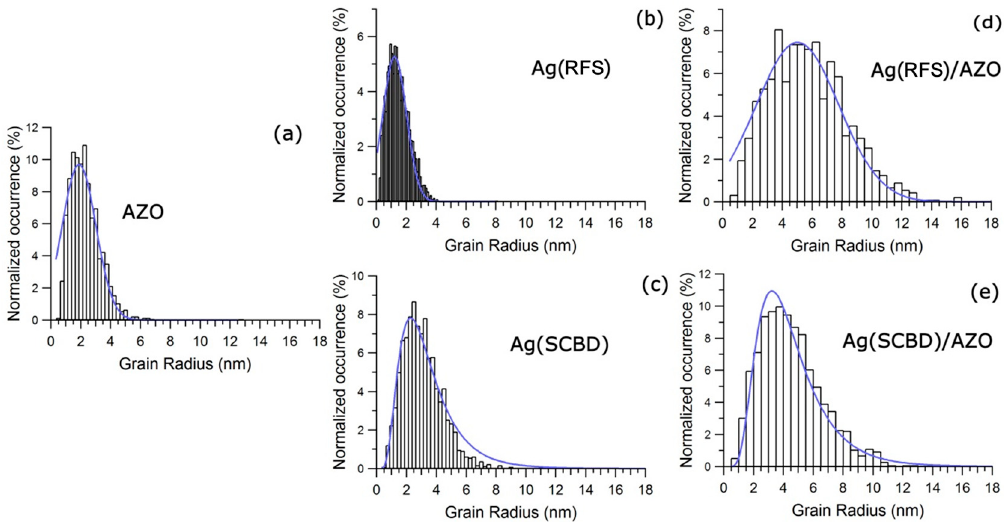
Figure 3. Nanoparticle height distributions obtained from the analysis of AFM data for samples deposited on PLA substrate: ( a ) AZO; ( b ) Ag(RFS); ( c ) Ag(SCDB); ( d ) Ag(RFS) / AZO; ( e ) Ag(SCBD) / AZO. The blue curves represent the best fit functions as described in the discussion.